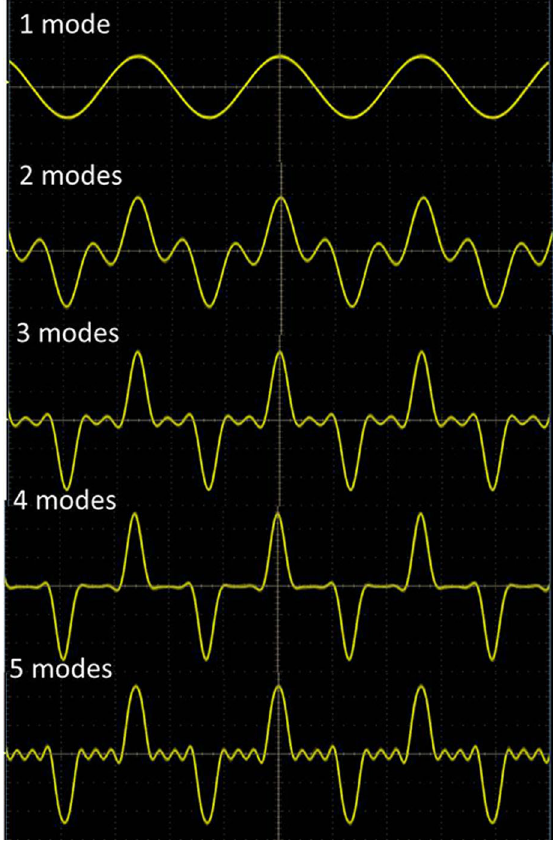
FIG. 22. The result of the odd harmonic modes combined one by one viewed on the oscilloscope display. Here the fifth mode is in the reverse phase to make the final kicking pulse more flat. The final working pulse is a flat-top kicking pulse which is the combination of a DC component and 10 continues harmonic modes separated in four cavities, here we just use five odd harmonic modes in the first cavity for a demonstration purpose.